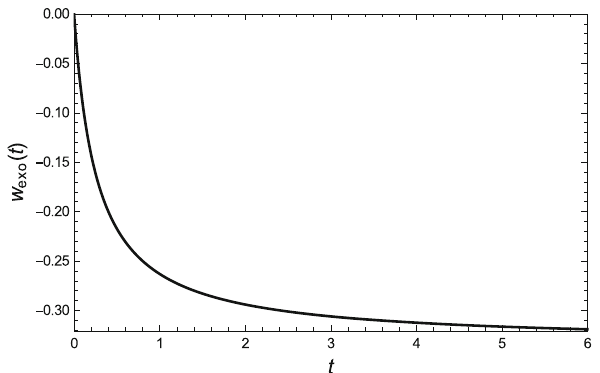
Fig. 9 Equation of state of the exotic fluid ω exo as a function of time. ω for the fluid distribution is chosen to be 0, and plotted for a negative